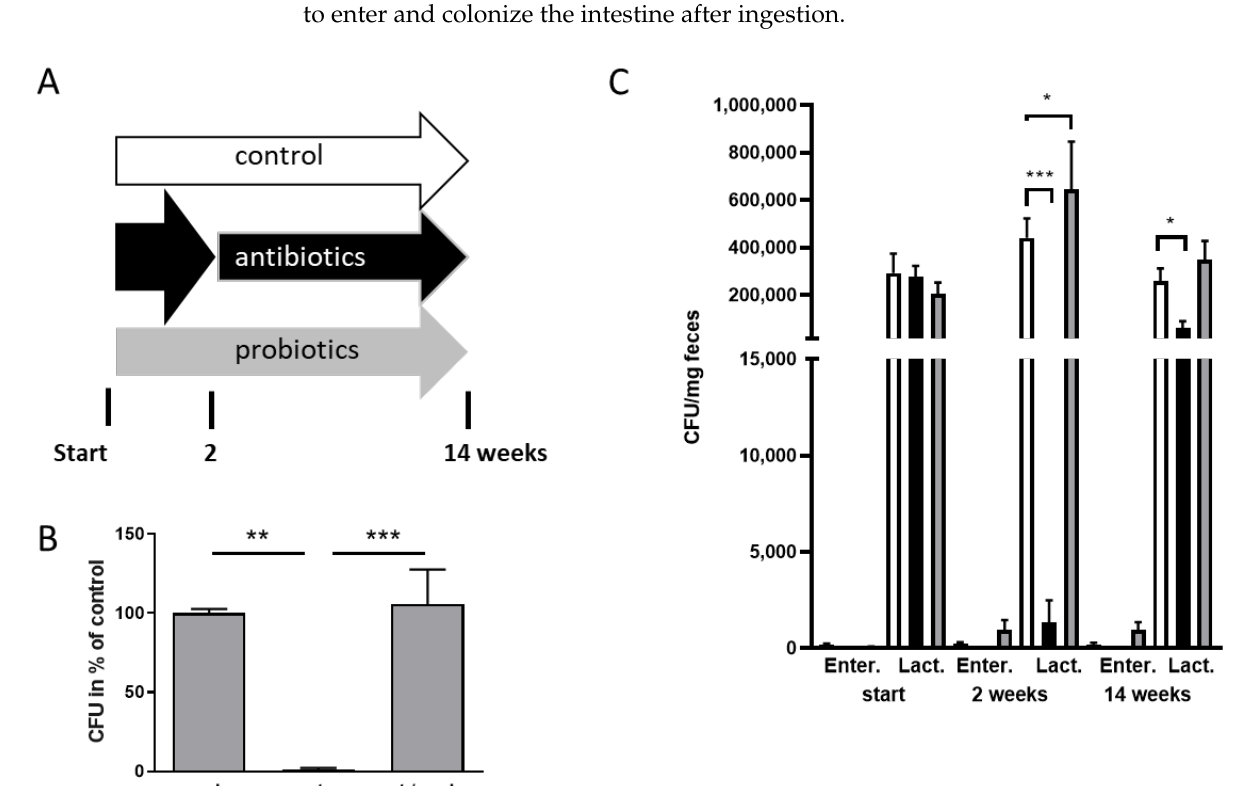
Figure 1. Manipulation of gut microbiota by application of antibiotics and probiotics with drinking water in 5xFAD mice. Male mice aged 4 weeks were subjected to three treatment groups: control, antibiotics or probiotics ( n = 8 for control, n = 7 for pro- and antibiotics each). Within the antibiotics group two weeks of high dosage and 12 weeks of low maintenance dosage were applied via the drinking water ( A , scheme). ( B ) To control for general viability of the orally administered probiotics within the intestinal passage, stomach contents from germ-free, gnotobiotic mice ( n = 18) were spiked with a defined amount of the probiotic bacteria, incubated for 70 min and plated on Lactobacillaceae -specific plates. As a positive control, probiotic bacteria in solvent were used, (prob., n = 8); stomach contents from the animals diluted with solvent served as a negative control (st.). Colonies observed after 20 h were counted (colony forming units, CFU) and normalized to the positive control. ( C ) Feces from the animals of the three treatment groups were collected at the indicated time points, diluted with sodium chloride and plated on Enterobacteriaceae - and Lactobacillaceae -specific plates. CFU were related to the used fecal material amount. Data are presented as mean + SEM. Statistical analysis was performed by one-way ANOVA with the appropriate post- test (B: Tukey’s, C: Fisher’s LSD; *, p < 0.05; **, p < 0.01; ***, p < 0.001).